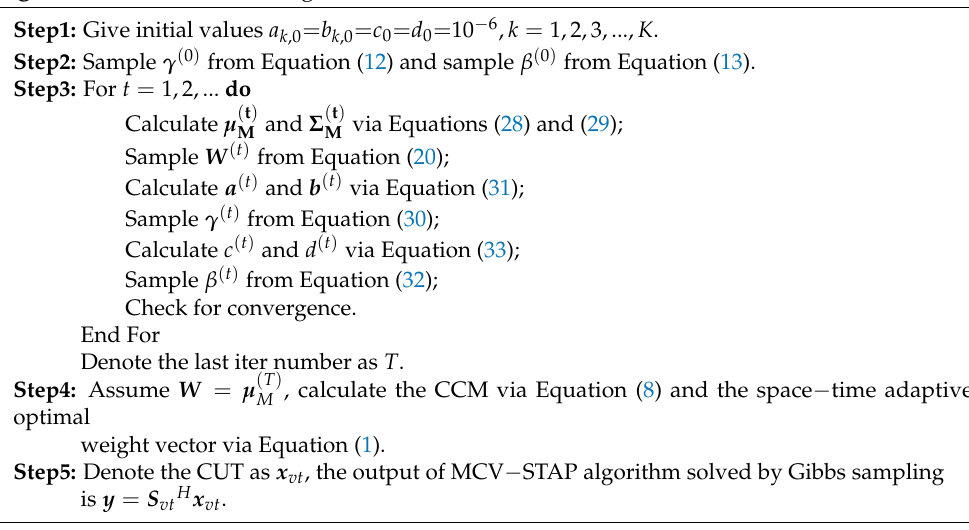
Algorithm 1 MCV − STAP